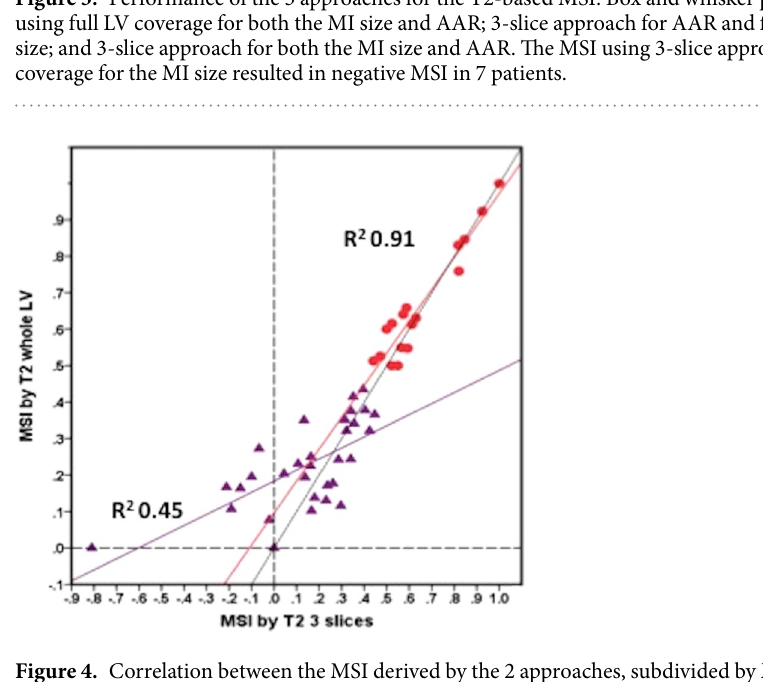
Figure 4. Correlation between the MSI derived by the 2 approaches, subdivided by MSI above or below 0.50. The dotted lines represent the line of identity. The dashed lines represent the lines passing through 0 on the x and